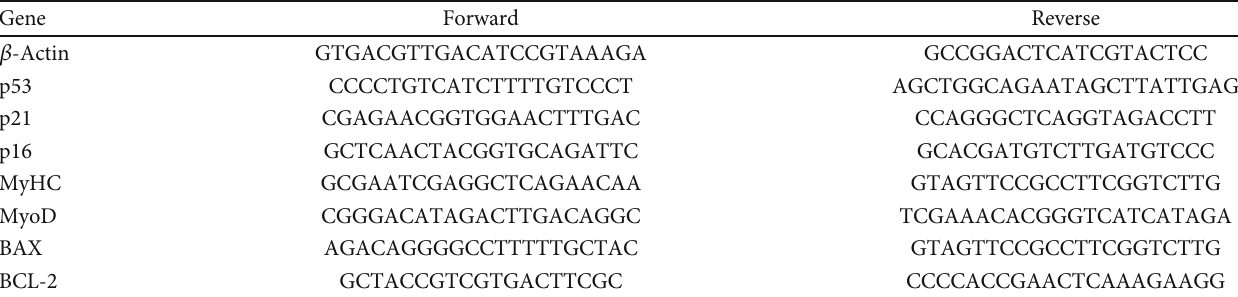
Table 1: Primer sequences for